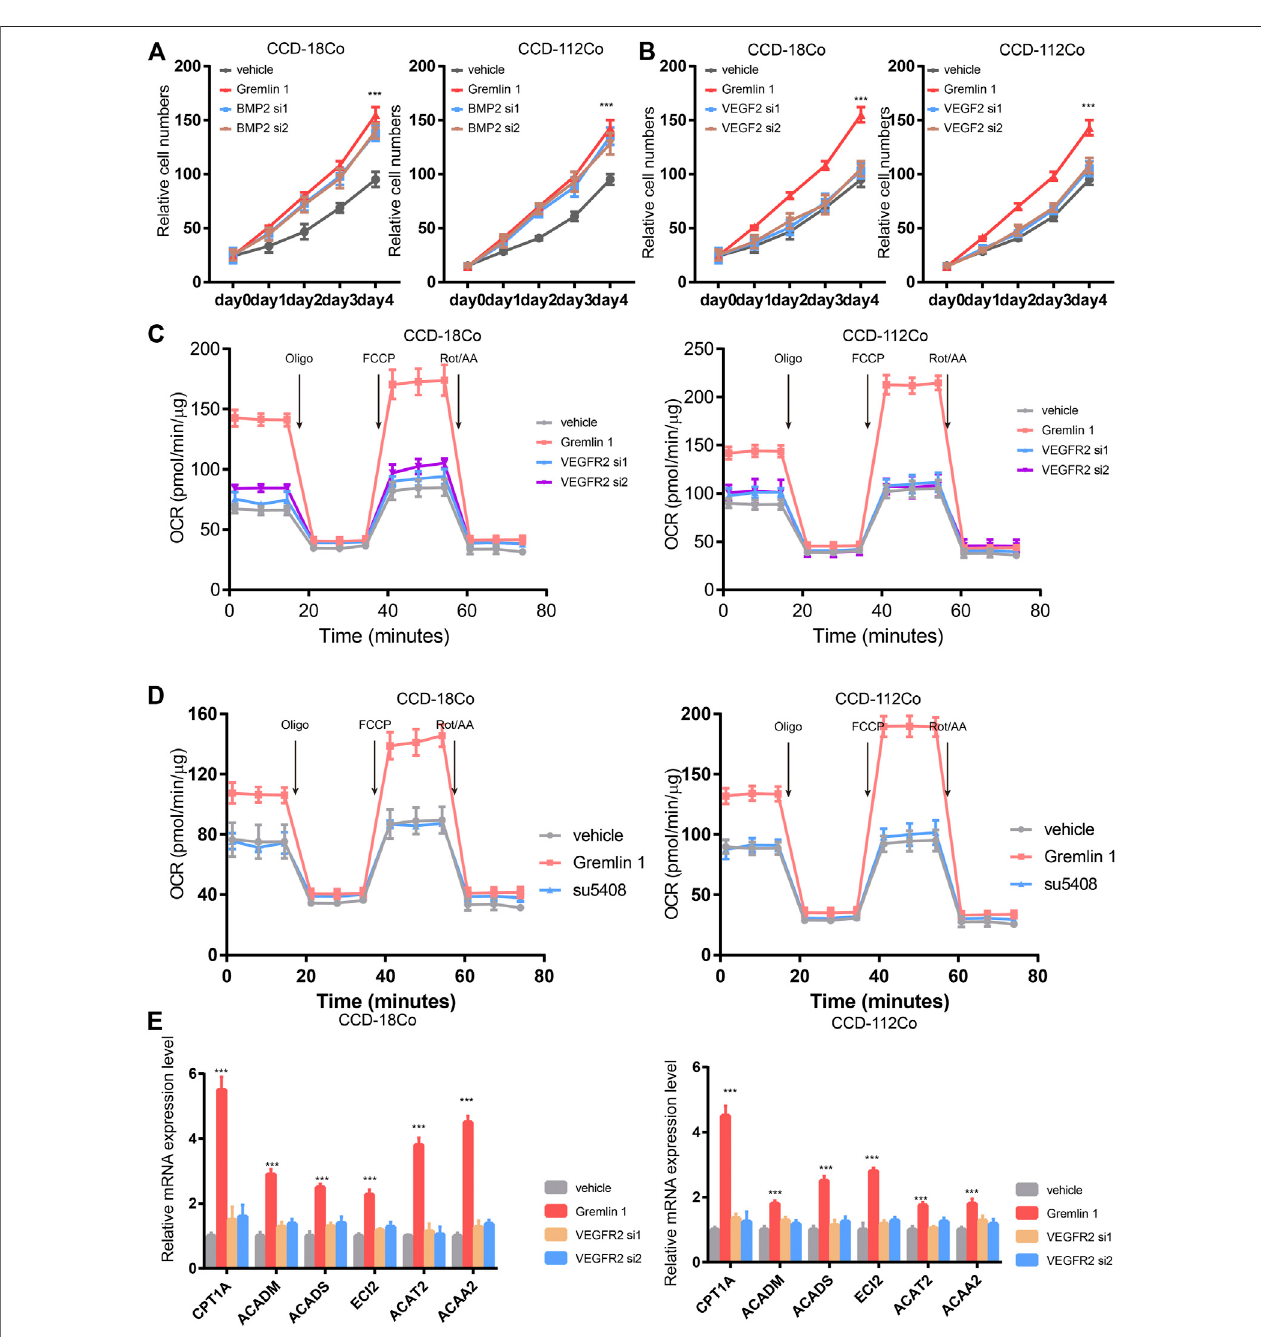
FIGURE 4 | Gremlin 1 activated VEGFR-2 to enhance the FAO of fi broblast. (A) . Cell viability assay of human intestinal fi broblast cells CCD-18Co and CCD- 112Co treated with 200 ng/ml Gremlin 1 with or with not silencing BMP2 with siRNA. (B) . Cell viability assay of human intestinal fi broblast cells CCD-18Co and CCD-112Co treated with 200 ng/ml Gremlin 1 with or with not silencing VEGFR-2 with siRNA. (C) . The OCR results of CCD-18Co and CCD-112Co cells treated with 200 ng/ml Gremlin 1 for 24 h, following silencing VEGFR-2 with siRNA or not. (D) . The OCR results of human intestinal fi broblast cells CCD-18Co and CCD-112Co cells treated with 200 ng/ml Gremlin 1, following VEGFR-2 inhibitor SU5408 (100 nM) treatment for 24 h. (E) . Q-PCR results of genes related with FAO metabolism in the human intestinal fi broblast cells CCD-18Co and CCD-112Co cells. p values are derived from two-sided Student ’ s t test. ** p ≤ 0.01; *** p ≤